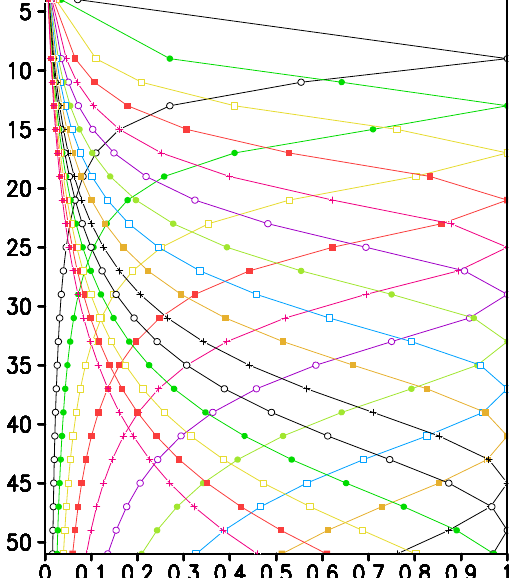
Fig. 1. Vertical correlations of the background error covariance. Each line labeled with different colors stands for a vertical correla- tion between one layer located at the right top of the line and